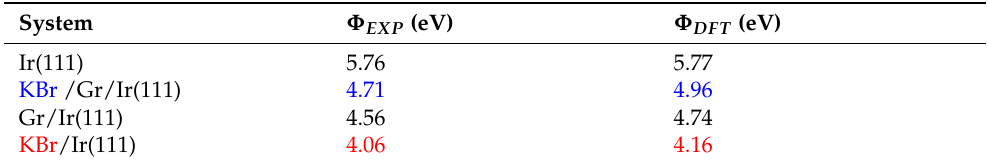
Table 1. Work function values experimentally observed by KPFM measurements and theoretically by DFT simulation results [23].